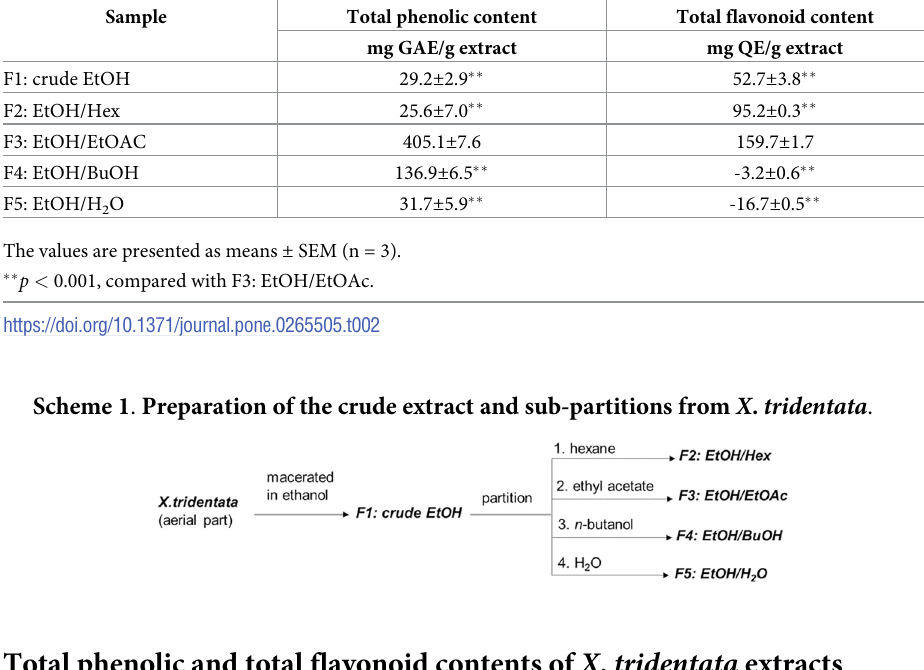
Table 2. Total phenolic and total flavonoid contents of the extracts of X . tridentata . Sample